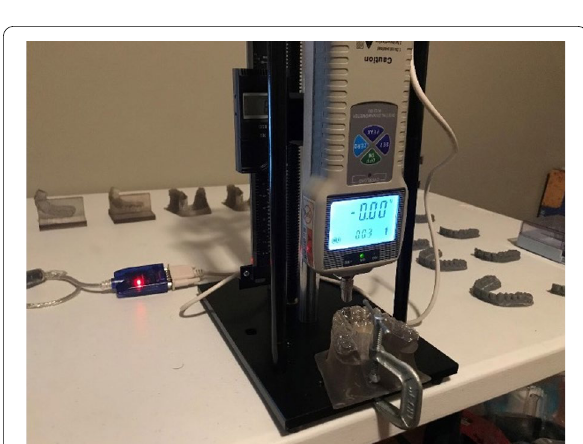
Fig. 3 Experimental Test Stand with dynamometer and integrated caliper prior to initializing displacement test of TFA aligner on the test